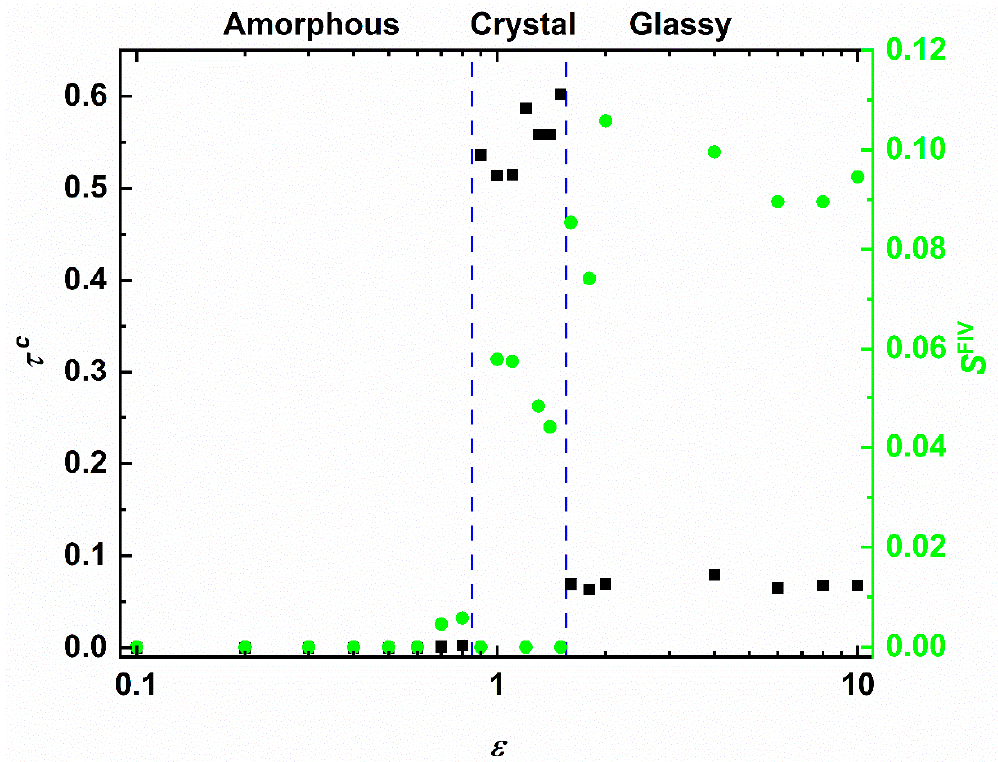
Figure 5. ( Left y -axis) Degree of crystallinity, τ c , ( = S HCP + S FCC ) and ( right y -axis) fivefold order parameter, S FIV , as a function of the interaction intensity, ε , of the square well potential for a fixed range ( σ 2 = 1.2) in log-linear scale. Vertical dashed, blue lines indicate the transition from amorphous to crystal and from crystal to fivefold-rich glassy regimes as dictated by the population of closed packed and fivefold sites and the corresponding established morphologies.